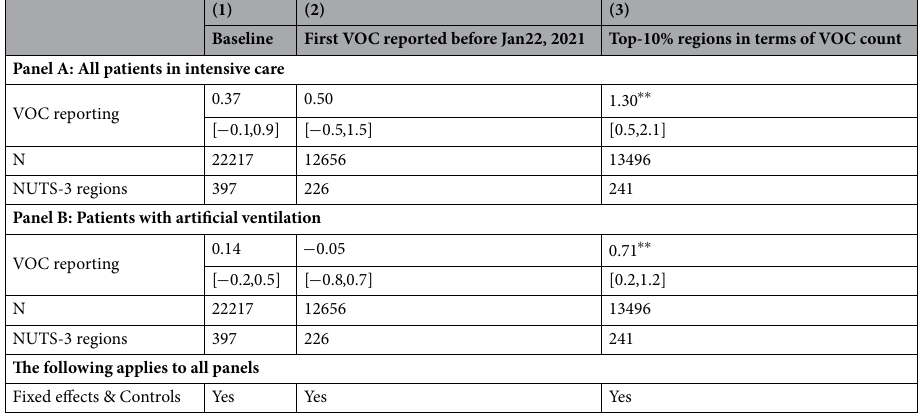
subsample defining the treatment groups as belonging to the top 10% (90th percentile) of absolute VOC counts. For the latter, we find an increase in the incidence rate of 32% on average (35.00 [CI 17.9, 52.1] additional cases per 100,000 population). Generally, the extension of treatment periods by 7, 14 and 21 days ahead of the first VOC results in smaller point estimates in all three panels (with declining statistical significance). This indicates that infection trends appear to change around the date of first VOC reporting and not significantly before that date. Confounding factors may challenge our estimates. We control for several potential confounders in the link between first VOC reporting and the 7-day incidence rate. These include daily mobility patterns and daily weather data at the regional level, time-invariant region-specific factors (through NUTS-3 level fixed effects), the geographical neighborhood of each NUTS-3 regions. The “Methods” section and the SI appendix contain further details and source descriptions.